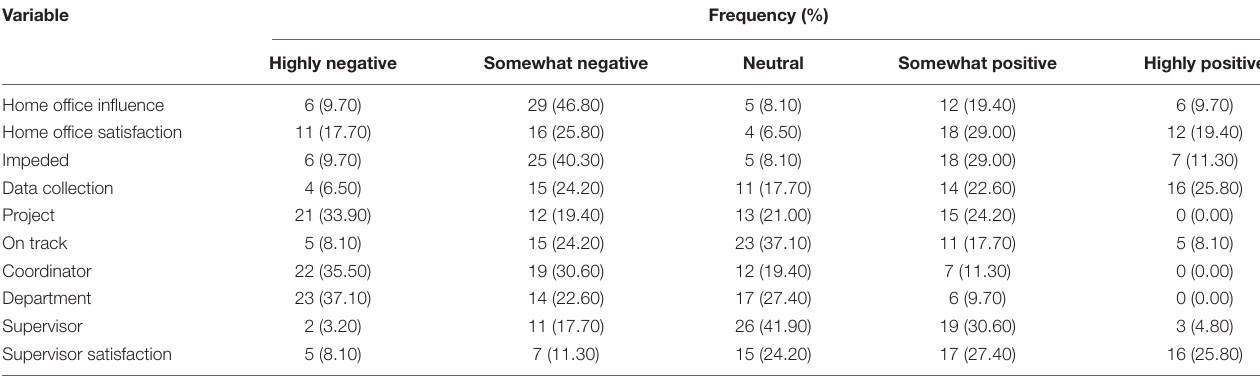
TABLE 1 | Descriptive overview: frequency and